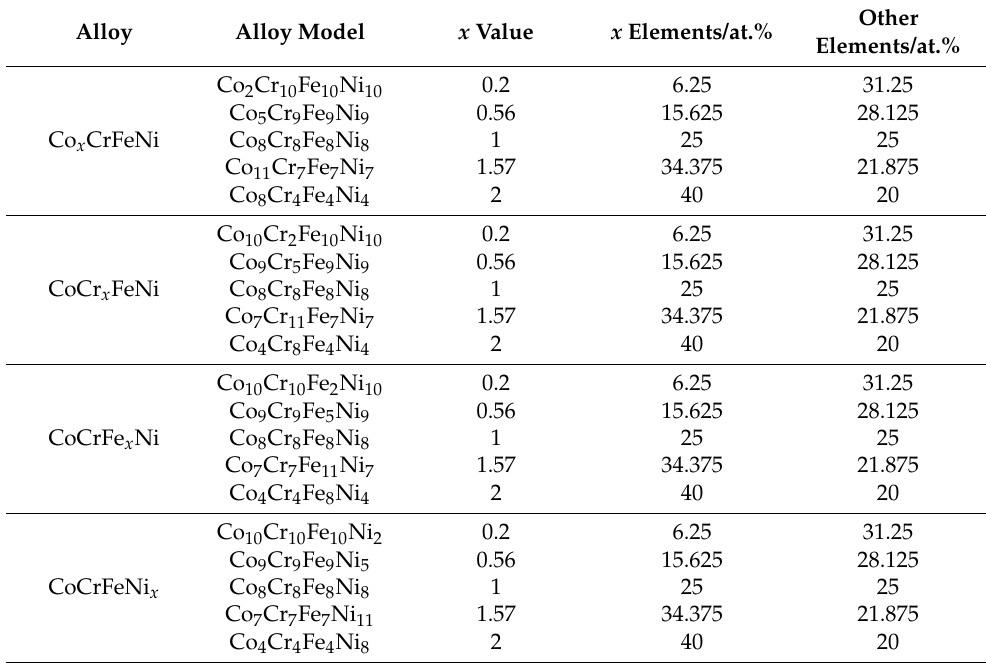
Table 1. Co-Cr-Fe-Ni high-entropy alloys (HEAs) model and the percentage of each element. Alloy Alloy Model x Value x Elements/at.%